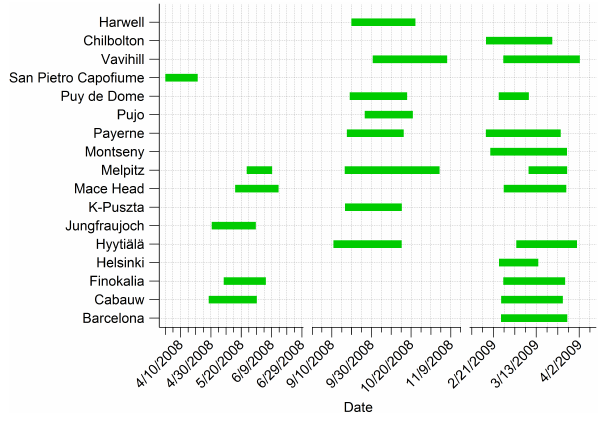
Figure 1. EUCAARI/EMEP campaigns 2008–2009: measurement